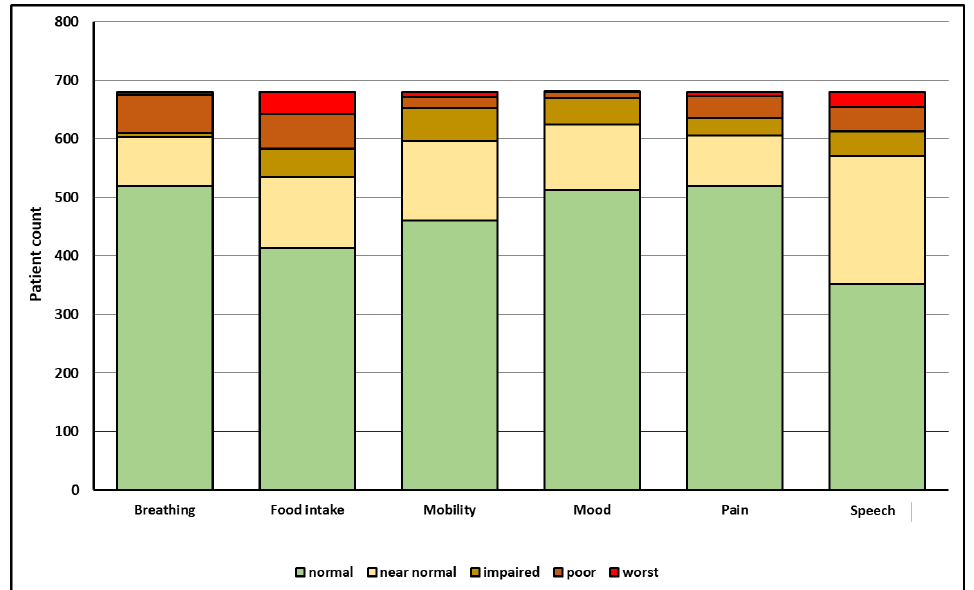
Figure 1. Outcome in six functional domains (x-axis) and respective number of HNC-patients (y-axis) at a median of three years after initial diagnosis as reported by the treating physicians using the HNC-FIT Scale. For related verbal ratings and relative patient count in percent, see Table 1.